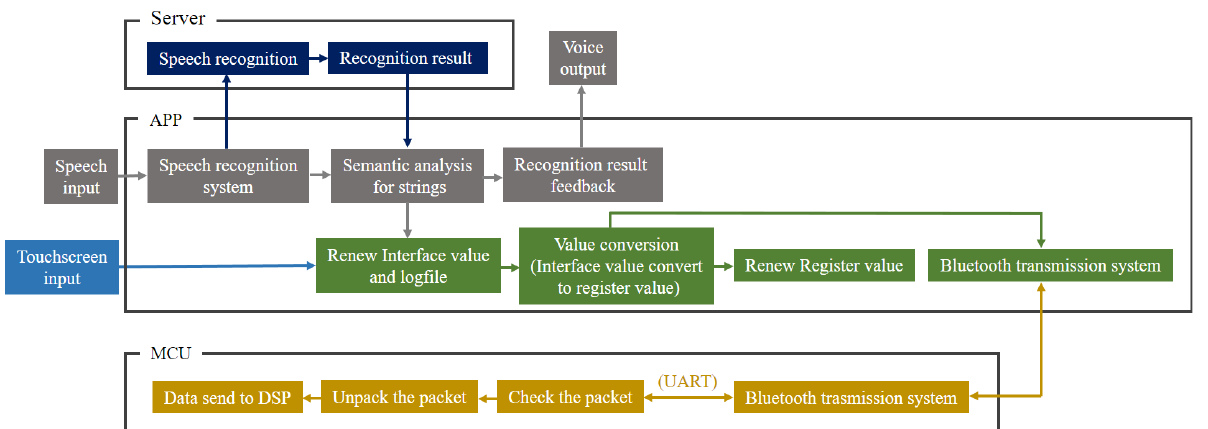
Figure 5. APP function block for the proposed smart digital mixer system.